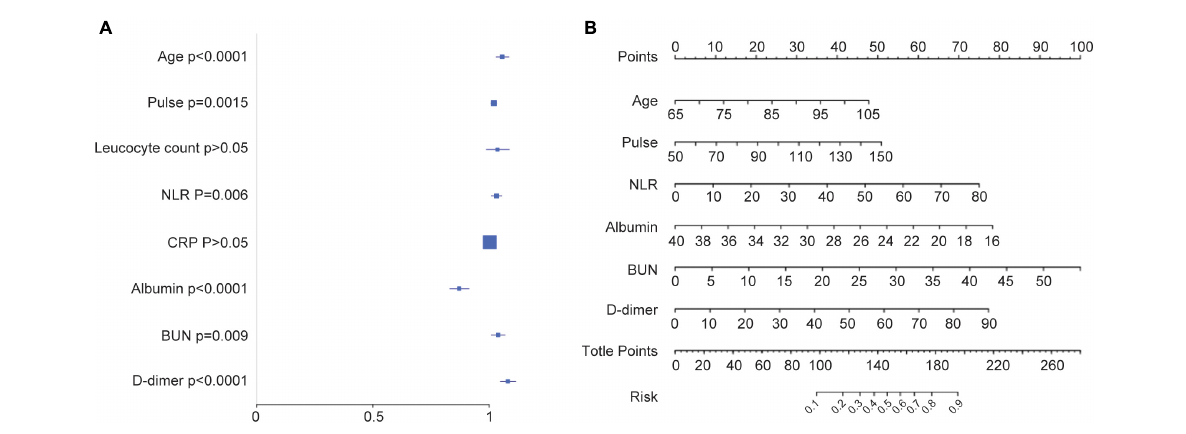
FIGURE3 Establishment of a nomogram model for predicting the mortality of elderly patients with CAP. (A) Forest map showing multivariate analyses. (B) The nomogram model for predicting the mortality of elderly patients with CAP. The nomogram factors included age, pulse, NLR, albumin, BUN, and D-dimer. The nomogram summed the scores for each scale and variable. The total score on each scale indicated the risk of mortality. NLR (neutrophil-lymphocyte ratio), BUN (blood urea nitrogen).